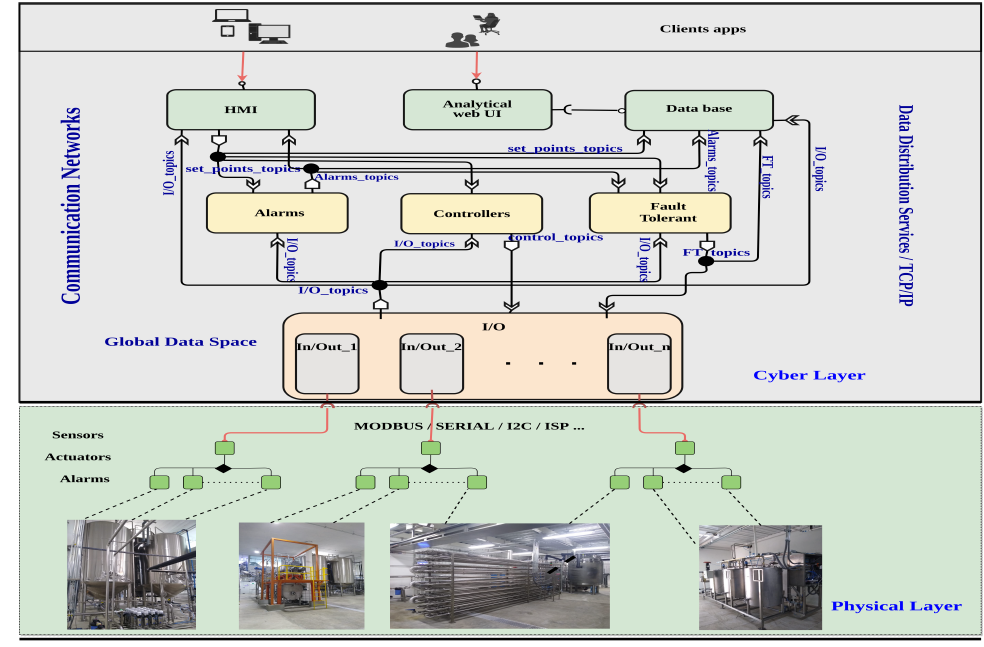
Figure 2. General component-based DDS